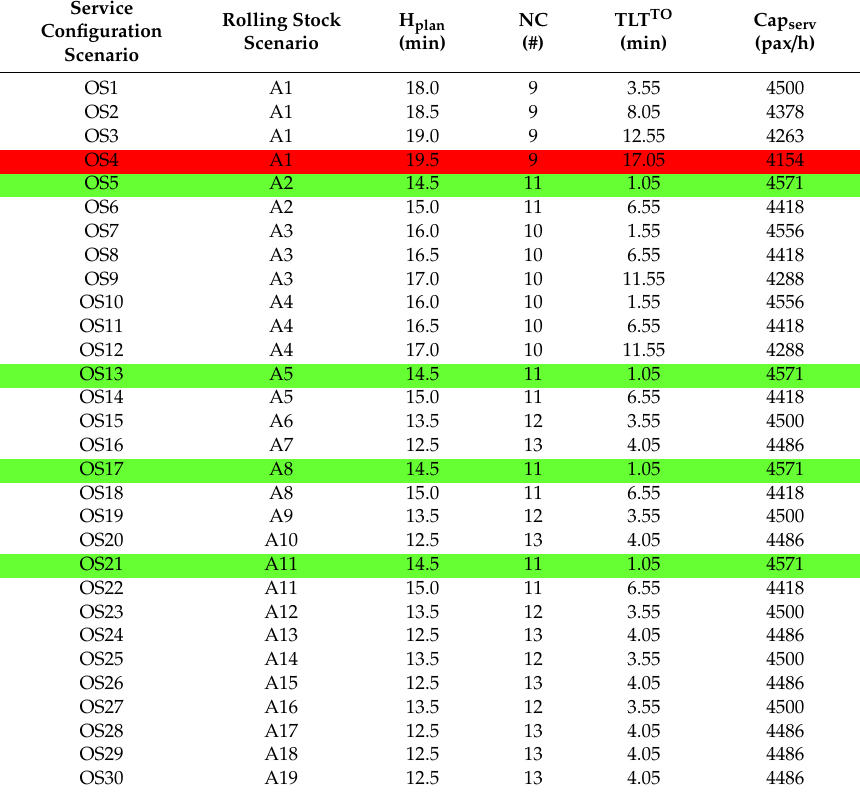
Table 3. Service configurations implementable in ordinary